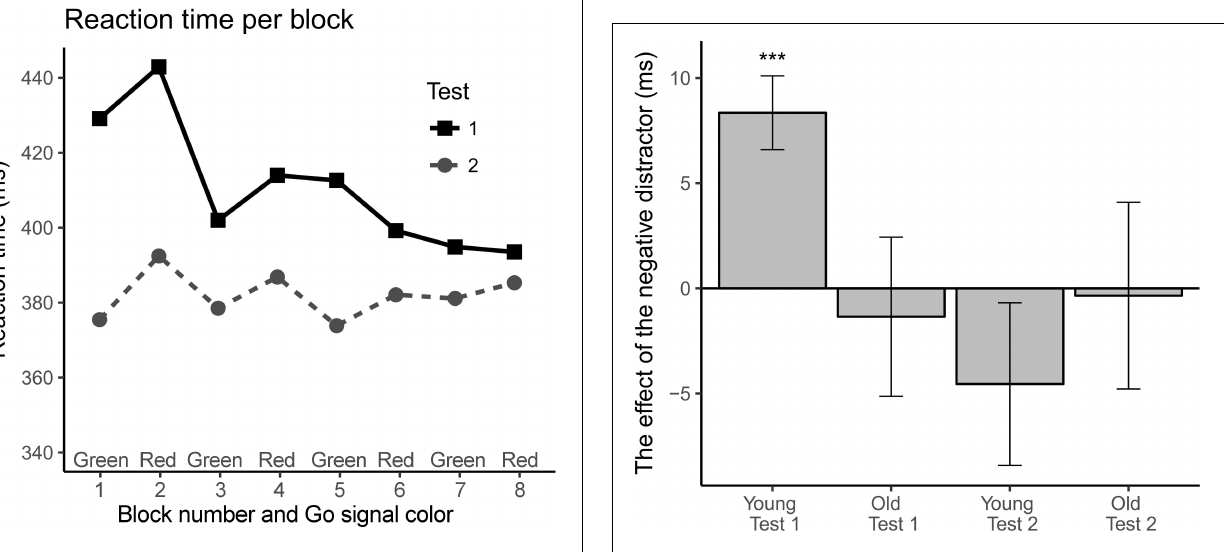
FIGURE 5 | The difference in task reaction times when negative distractor (gray bars) was presented in contrast to when neutral distractor was presented (baseline). Error bars represent standard error of the mean difference. Emotionally negative distractor slowed reaction times in young subjects in the first test. ∗∗∗ Statistically significant difference ( p <